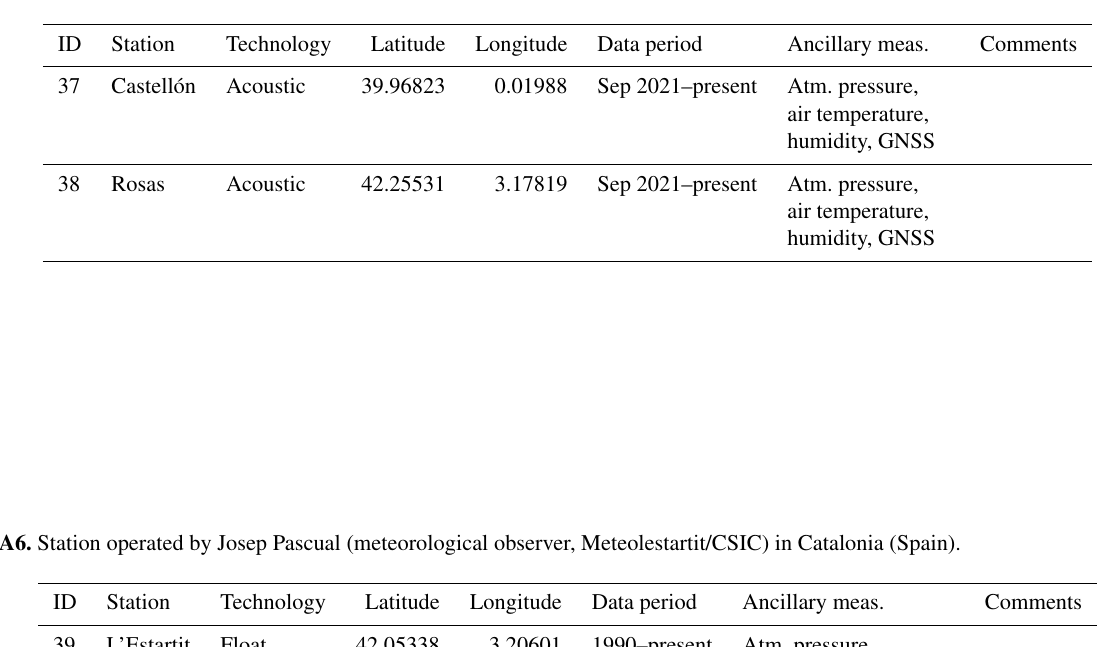
Table A5. Stations operated by Spanish Hydrographic Office in the Mediterranean Sea and data availability.